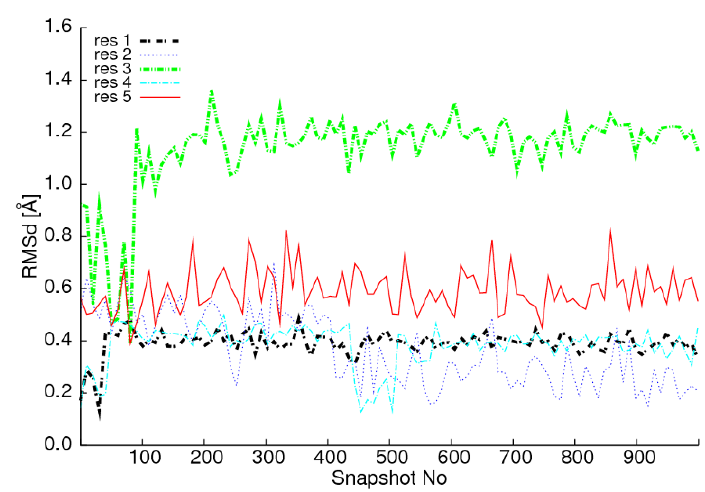
Figure 6. P lot of RMSd changes of LA-DA during unconstrained